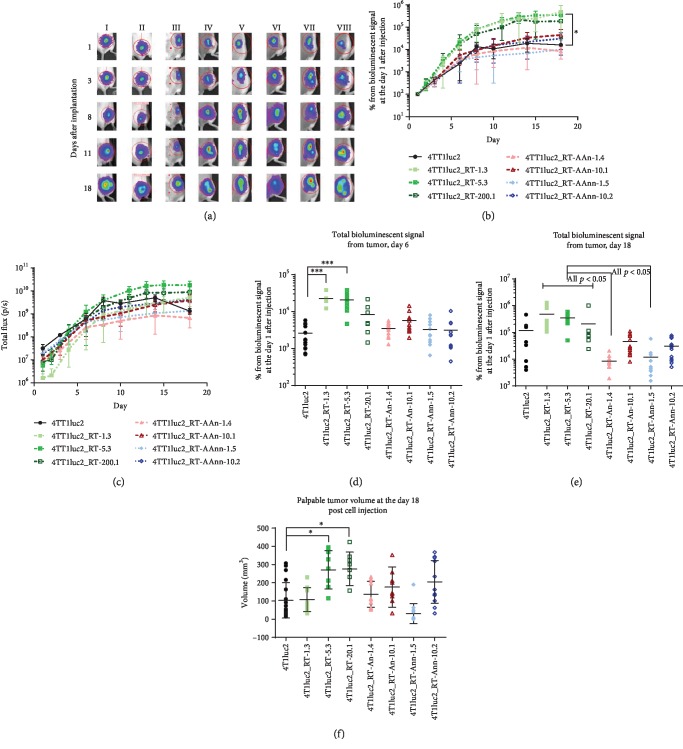
Formation of solid tumors by the derivative clones of 4T1luc2 expressing variants of HIV-1 FSU_A reverse transcriptase (RT_A) after ectopic implantation into BALB/c mice. In vivo bioluminescent images showing growth of representative tumors formed by clones 4T1luc2_RT-1.3 (I), 4T1luc2_RT-5.3 (II), 4T1luc2_RT-20.1 (III), 4T1luc2_RT-An-1.4 (IV), 4T1luc2_RT-An-10.1 (V), 4T1luc2_RT-Ann-1.5 (VI), 4T1luc2_RT-Ann-10.2 (VII), and parental cells 4T1luc2 (VIII); red circles show the regions of interest (ROI) from which the total luminescent signal was collected (a). Growth of tumors assessed as the average total photon flux from the sites of injection encircled by ROI (b), the average percent change in the total photon flux compared to the photon flux from the site obtained on day 1 (c), the total photon flux from each of the injections sites on days 6 (d) and 18 (e) as percent of that on day 1, and palpable tumor size at the experimental endpoint (f). All group values represent the mean ± SD. After day 3, 4T1luc2_RT-1.3 and 4T1luc2_RT-5.3 derivative clones demonstrated significantly higher total photon flux, and 4T1luc2_RT-20.1 tended to have higher photon flux (p = 0.1) than the parental 4T1luc2 cells. ∗p < 0.05, ∗∗p < 0.005, ∗∗∗p < 0.0005, and ∗∗∗∗p < 0.0001, Kruskal-Wallis, followed by Mann-Whitney tests.